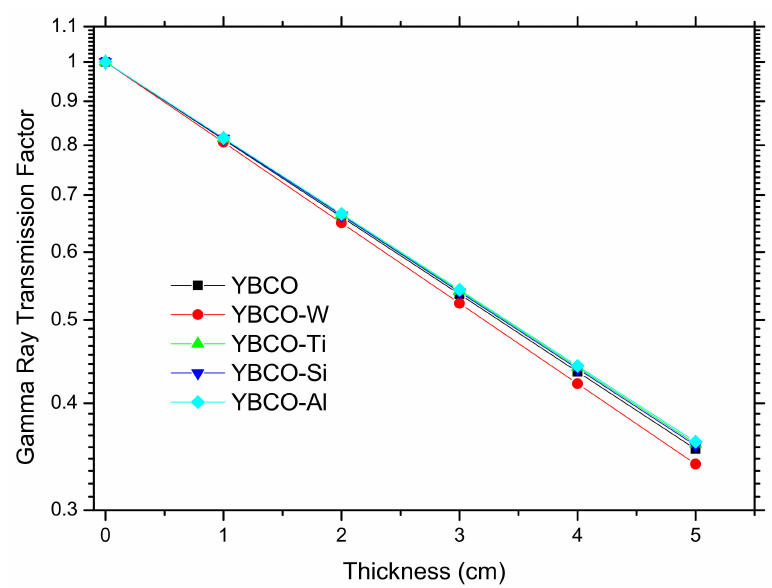
Figure 10. Transmission factor for the prepared ceramics versus the